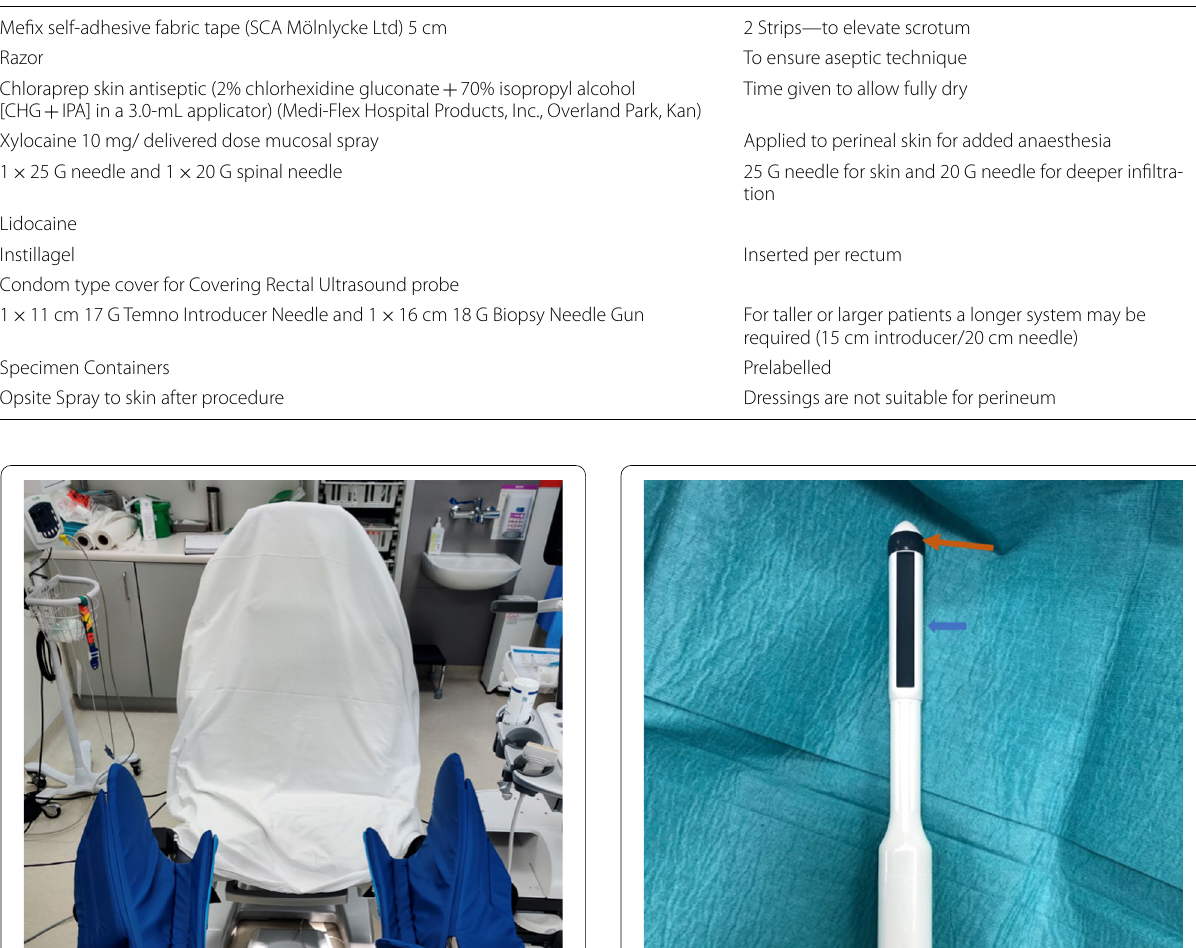
Table 1 Equipment required to perform a transperineal prostate biopsy Equipment